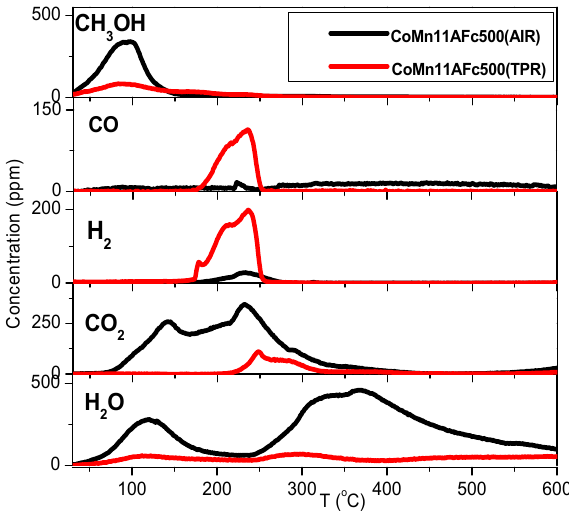
Figure 11. CH 3 OH ‐ TPD on CoMn11AFc500(AIR) and CoMn11AFc500(TPR). Figure 11. CH 3 OH-TPD on CoMn11AFc500(AIR) and